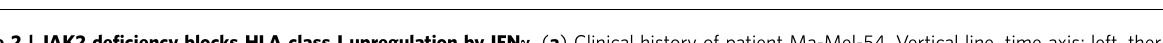
Figure 2 | JAK2 deficiency blocks HLA class I upregulation by IFN c . ( a ) Clinical history of patient Ma-Mel-54. Vertical line, time axis; left, therapeutic regimens; right, primary tumour (PT)/metastases development; arrows indicate cell lines established from metastases Ma-Mel-54a and Ma-Mel-54b; grey box, stage IV disease. ( b ) Mutations defined by targeted sequencing on DNA from melanoma cells and autologous blood cells as wild-type (WT) control (ctrl). Plots of aligned sequencing reads in the location where the JAK2 c.2876A 4 C, p.Q959P mutation was identified. WT sequences shown on the bottom, arrows highlight mutation sites. Number of sequencing reads notated on the left; %, frequency of mutations in reads. ( c ) Lysates from Ma-Mel-54a, Ma-Mel-54b and control cells (ctrl) analysed by western blot for JAK2 expression. ( d ) Lysates from IFN g -treated (48h) Ma-Mel-54a and Ma-Mel-54b cells analysed for expression of STAT1, pSTAT1, IRF1 and HLA class I heavy chains. ( c , d ) GAPDH, loading control. Representative data from n ¼ 2 independent experiments. ( e ) Expression of CD54, HLA class I and PD-L1 on IFN g -treated (48h) melanoma cells, measured by flow cytometry. Representative data from n ¼ 3 independent experiments. ( f ) SNP results given as allelic distribution of chromosome 9p shown for DNA obtained from Ma-Mel-54a, Ma-Mel-54b and autologous peripheral blood cells as normal control (germline). Loss of one chromosomal allele in region 9p24.3–p13.2 (Chr.9:203,861-37,578,327; hg19) present in both cell lines. Dashed line indicates JAK2 location at Chr.9p24.1. ( g ) Lysates from IFN g -treated (48h) Ma-Mel-54a-JAK2 transfectants analysed by western blot for expression of indicated proteins. ( h ) Real-time cell proliferation in the presence or absence of IFN g . Bold grey vertical lines indicate addition of IFN g . ( g , h ) Representative data from n ¼ 2 independent experiments. ( i ) Ma-Mel-54a and Ma-Mel-54b cells analysed for specific mRNA expression by quantitative reverse transcription–PCR. ( j ) Ma-Mel-54a-JAK2 transfectants analysed for specific mRNA expression by quantitative reverse transcription–PCR in the presence or absence of IFN g (48h). ( i , j ) Relative expression levels given as means ( þ s.e.m.) from n ¼ 2 independent experiments. ( k ) HLA class I expression on IFN g -treated (48h) Ma-Mel-54a cells and Ma-Mel-54a-JAK2 transfectants, measured by flow cytometry. Representative data from n ¼ 2 independent